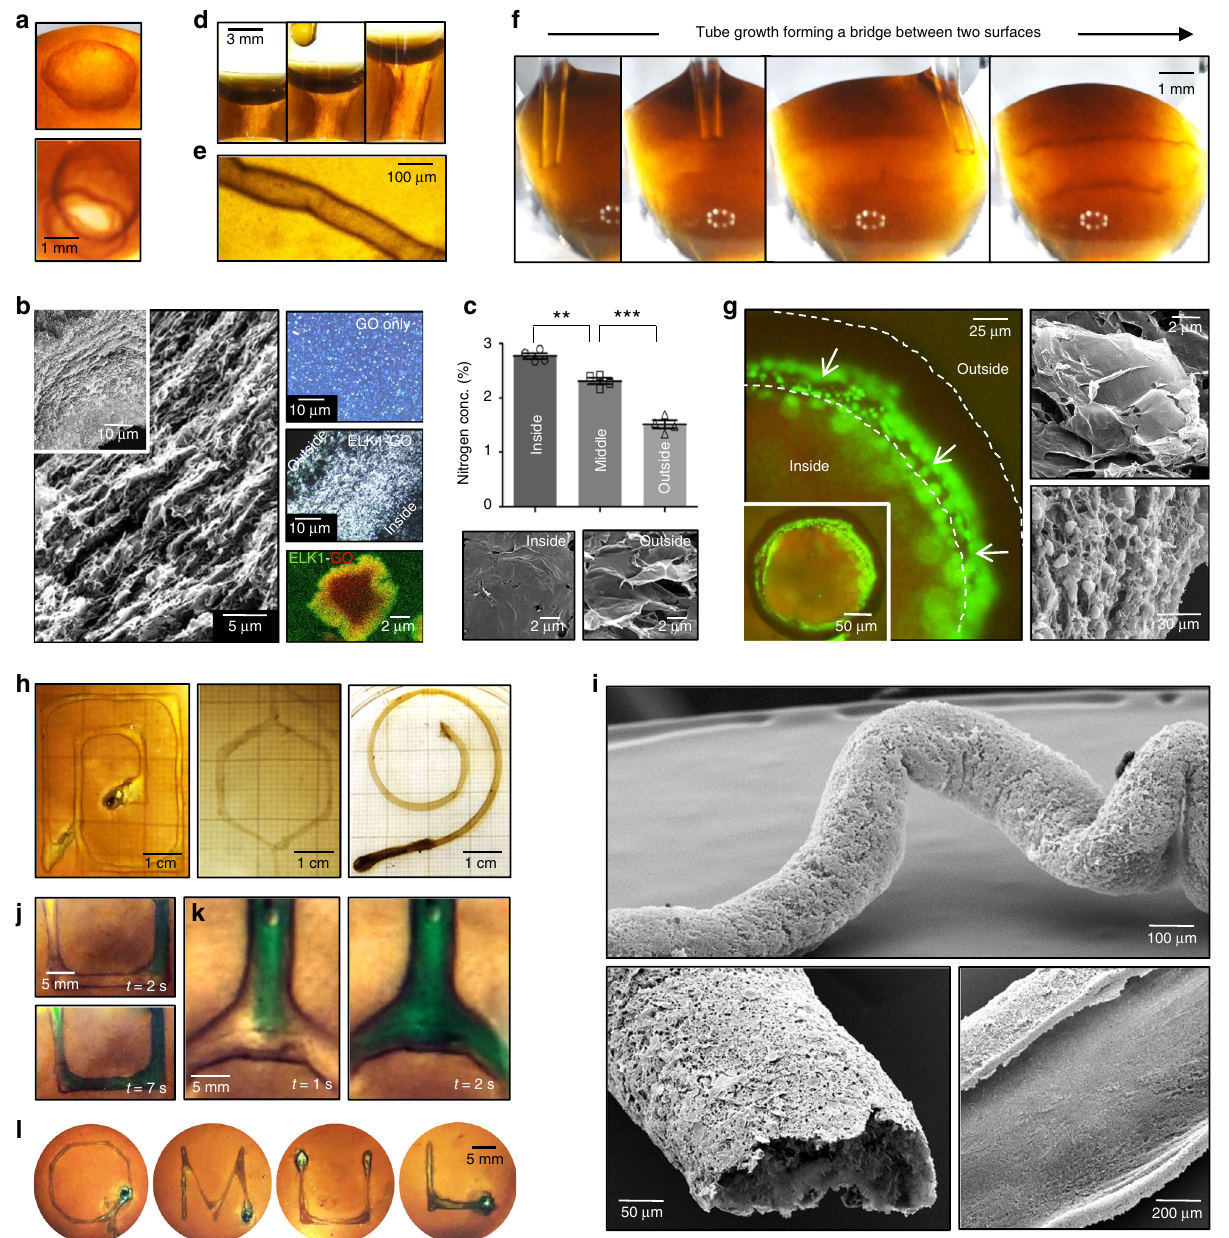
Fig. 2 Co-assembly, structure, properties, and biofabrication of the ELK1 – GO system. a Time-lapse images illustrate the dynamic properties of the ELK1 – GO membrane fi rst ( a -Top forming a closed sac when a drop of ELK1 solution is immersed in a larger GO solution and second ( a -Bottom) opening upon touching an interface within the fi rst seconds of formation. b The membrane exhibits a multi-layered architecture of about 50 μ m thick comprising aligned GO sheets throughout (birefringence inset) interacting with ELK1 molecules ( fl uorescence image, green: ELK1, red: GO), c which are observed to decrease in concentration from the inside to the outside as evidenced by wavelength-dispersive spectroscopy (WDS). Only ELK1 comprises nitrogen in its molecular structure. ±s.d. for n = 3. * p < 0.05. t test. d The system enables growing the membranes into longer tubes on demand by displacing an interface. e The robustness of the system enables formation of capillaries down to about 50 μ m in internal diameter with 10 μ m thick walls, f bridging of surfaces simply by touching two interfaces while injecting one solution into the other, and g co-assembling in salt solutions, opening the possibility to embed cells (green identi fi ed by white arrows) within the membrane (outlined by dashed lines) as the tubes are formed. The images are taken after 24 h of culture and correspond to a live (green)/dead (red) assay. Scanning electron micrographs of cells embedded within layers of GO (top) and a cross-section of the ELK1 – GO membrane comprising cells within different layers (bottom). h – l Images demonstrate the versatility of the co-assembly system by incorporating it with 3D printing to fabricate well-de fi ned fl uidic devices consisting of high-aspect ratio tubular structures ( h ) of different internal diameters and comprising curves, angles of different sizes, and bifurcations ( h , i , l ) capable of withstanding fl ow within a few minutes of formation ( j , k